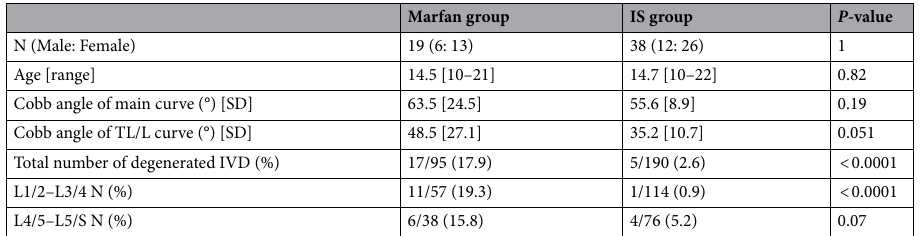
Marfan group IS